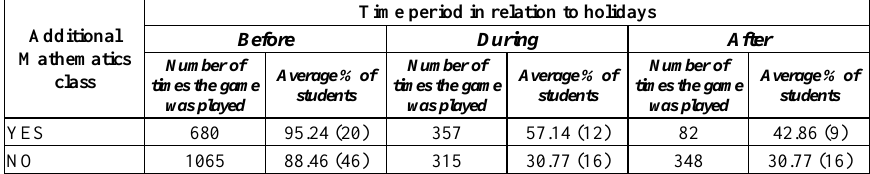
Table 4. Playing the game “Zagonetke mudrog lisca” grouped per time